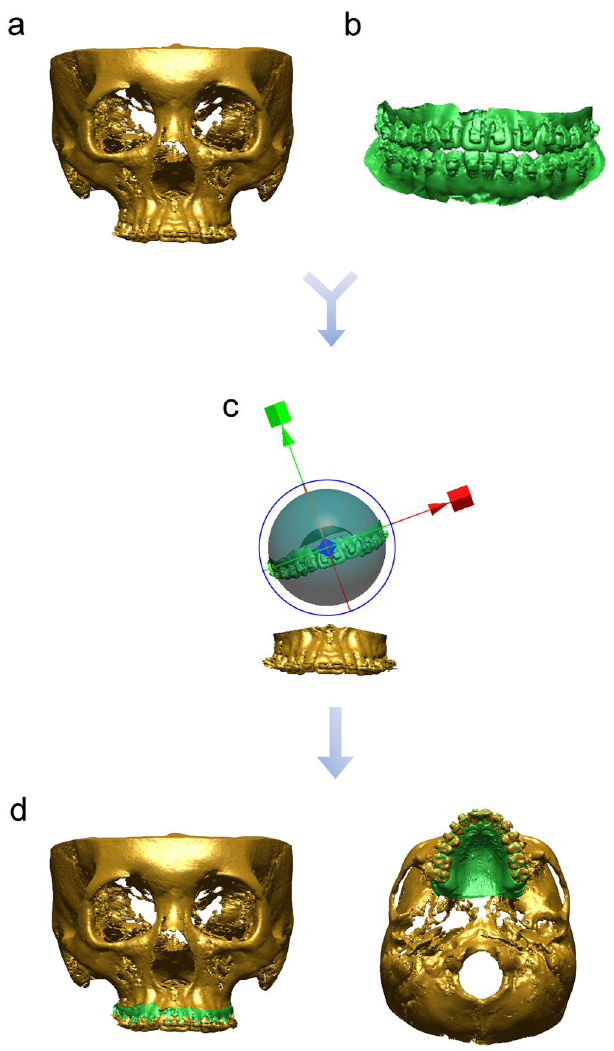
Figure 3. Study workflow of the integration of maxillary digital models into CBCT scans. ( a ) Reconstructed CBCT image, ( b ) digital cast image, ( c ) integration process of maxillary digital cast images into the dental portions of reconstructed CBCT images, ( d ) integrated skeletodental